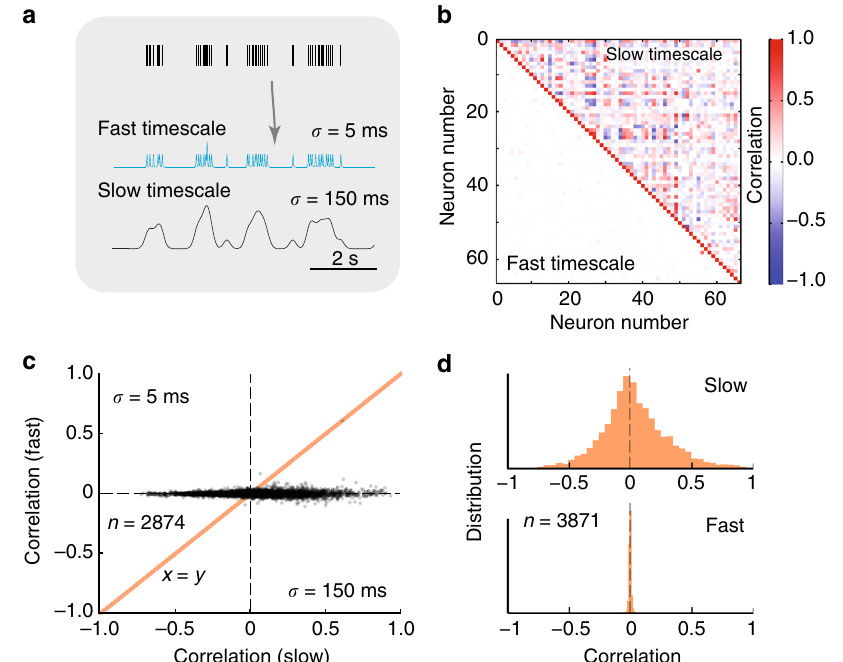
Fig. 7 Decoupling of slow and fast-spiking timescales. a Spike trace separated into slow and fast activity by convolving spike times with different Gauss – kernels ( σ = 5 and 150 ms). b Correlation matrix for the neuronal spiking on fast (lower left) and slow timescales (upper right) indicate a decoupling between the functional relation across pairs of neurons and their synaptic input. c Pairwise correlation on slow ( x -axis) and fast timescales ( y -axis) indicate a decoupling and departure from the unity line (orange). n = 2874 pairs, two hemicords. d Histogram of slow correlation (top) is broadly scattered whereas the fast correlation is scattered tightly around zero